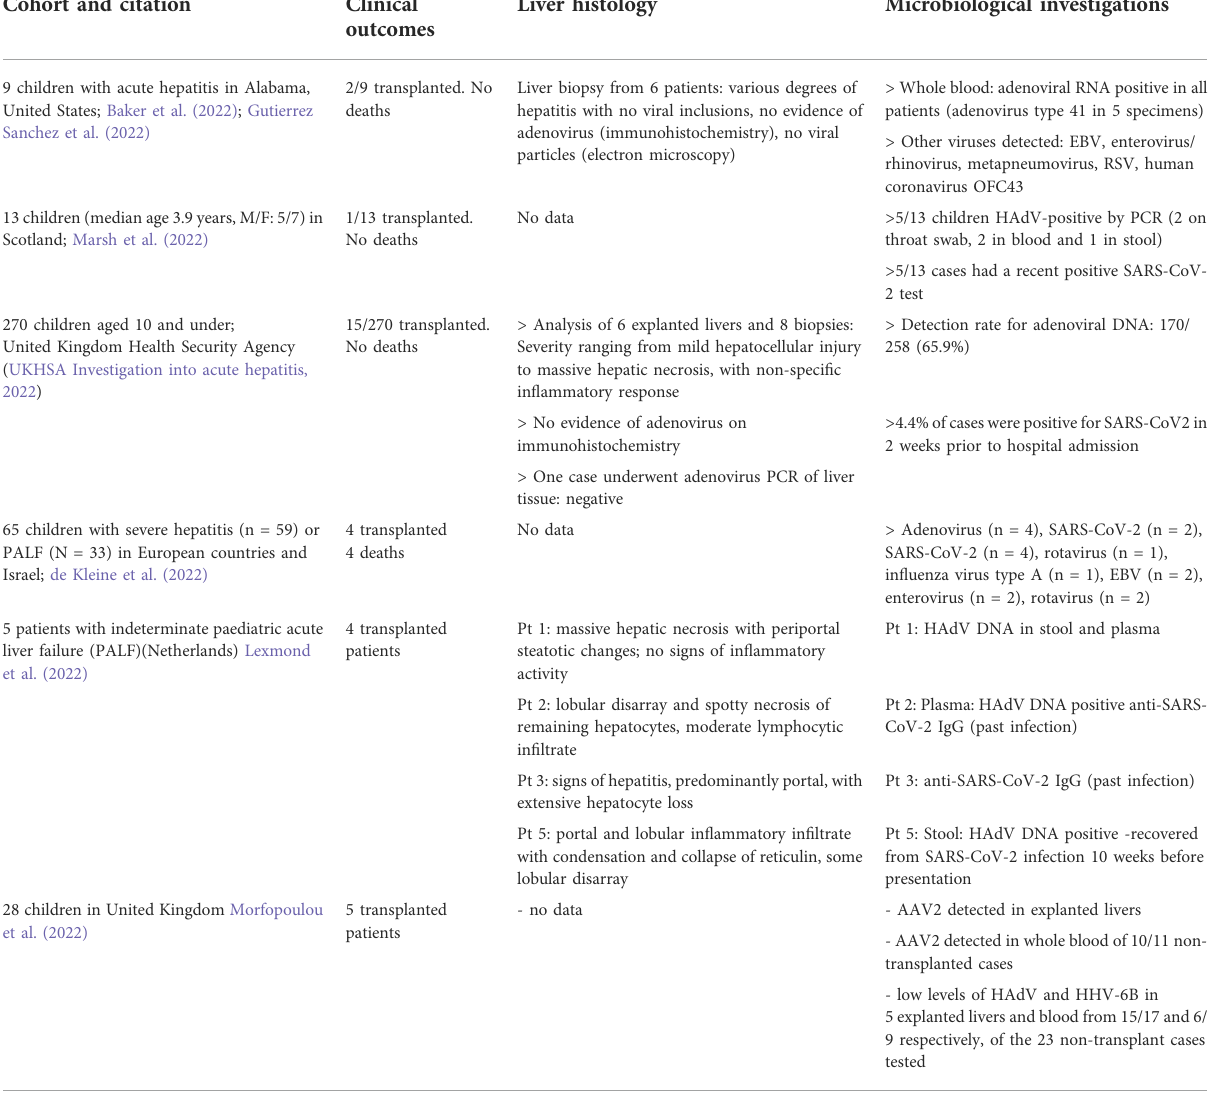
TABLE 3 Summary of data presented from United States, United Kingdom and European case series of children with AS-Hep-UA. Cohort and